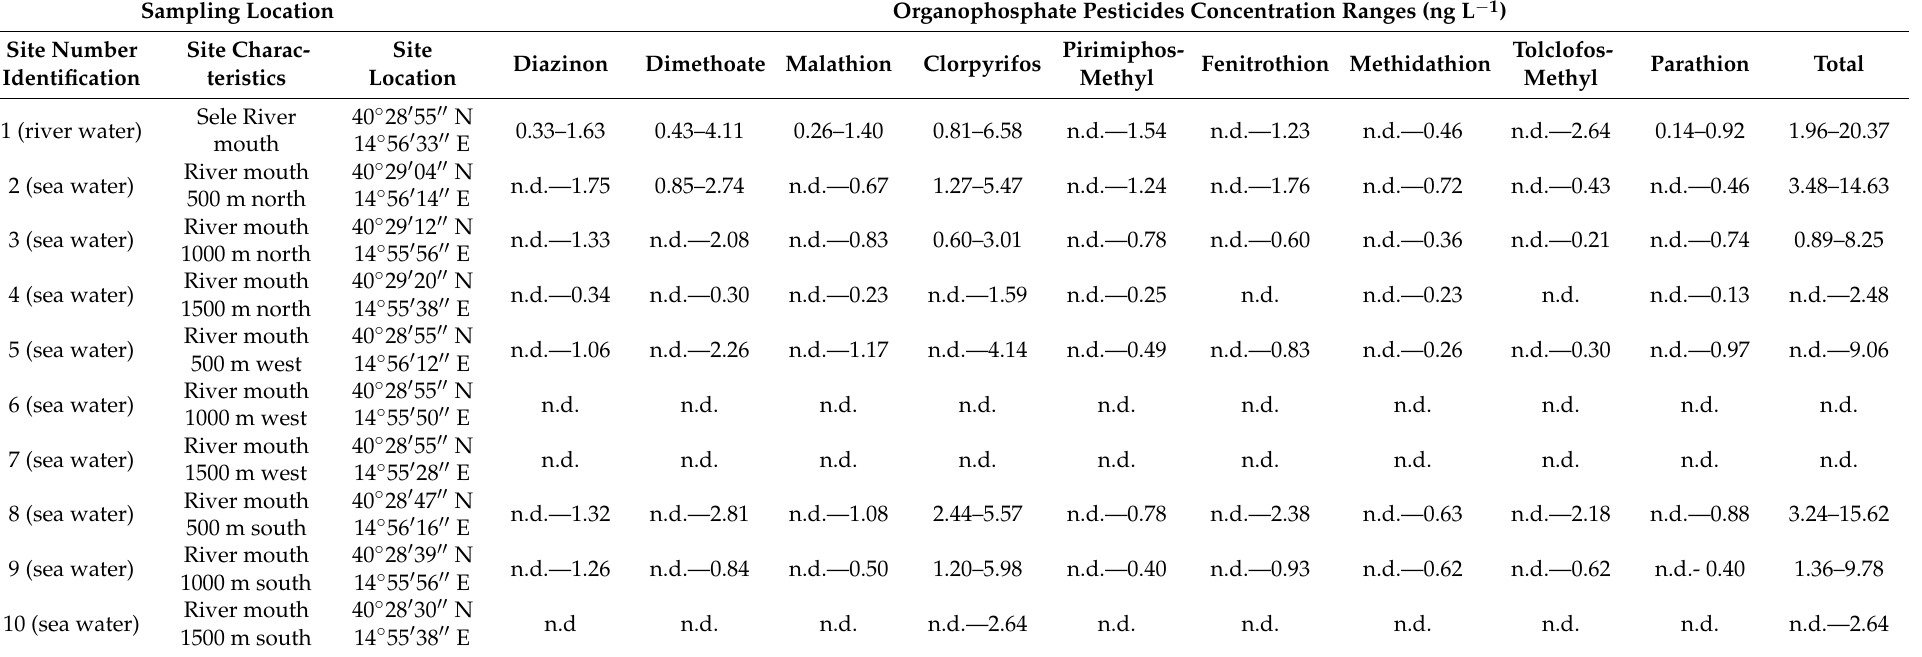
Table 3. Description of the sampling sites and OPP concentration range (ng L − 1 ) detected in the suspended particulate matter (SPM) samples from the Sele River, Southern Italy during four sampling